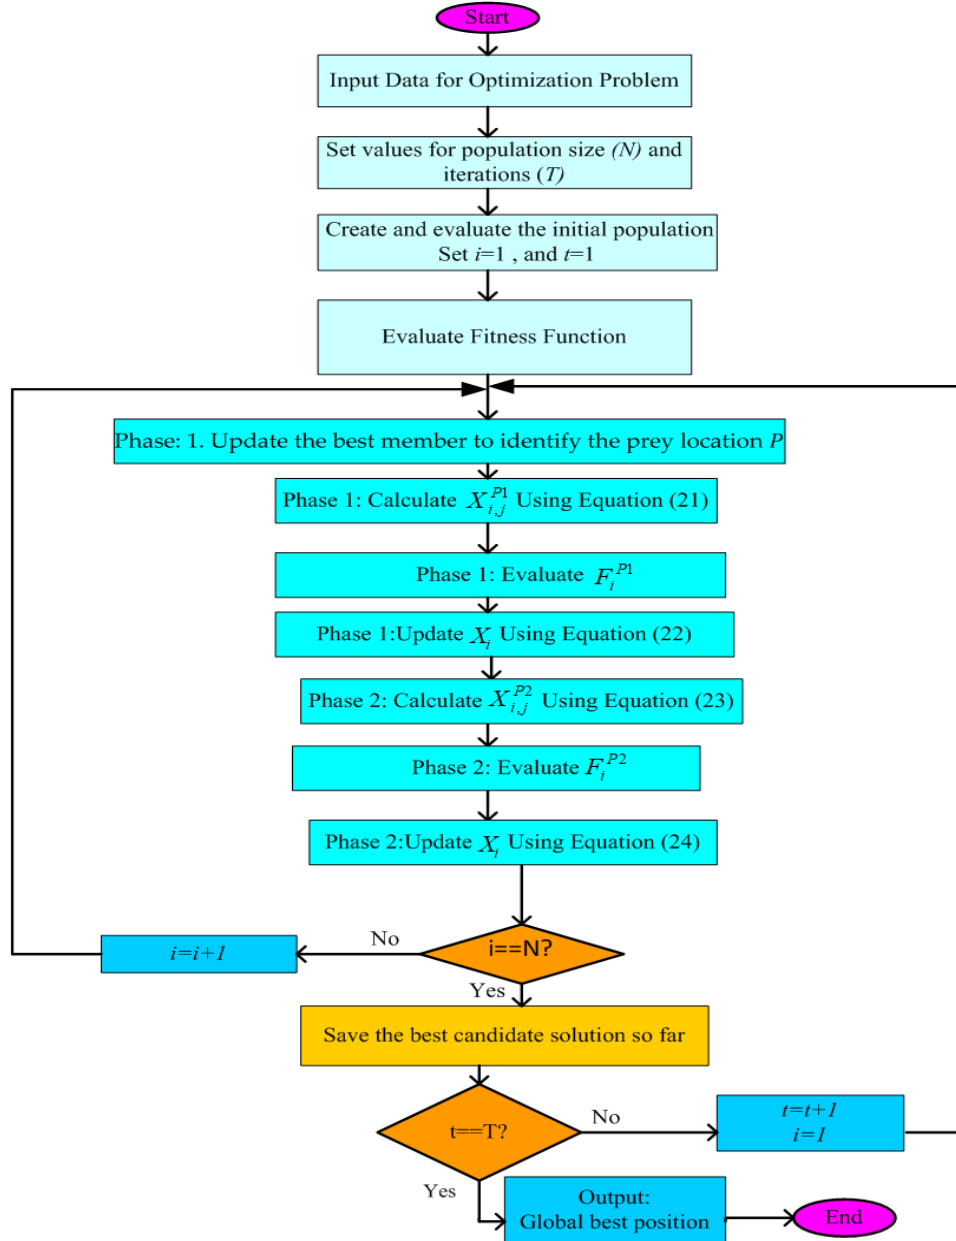
Figure 3. Flow chart of the SOA.